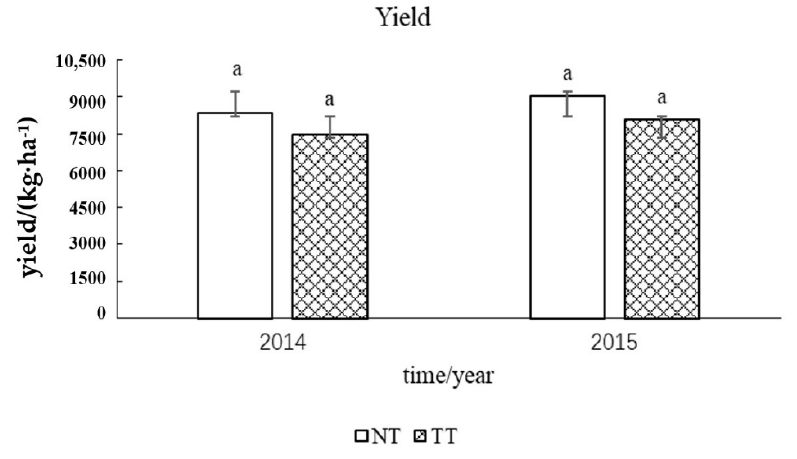
Figure 4. Summer maize yield from 2014 to 2015; NT: no tillage with straw cover; TT: traditional tillage with conventional ploughing. Means within each depth followed by the same letter were not significantly different ( p >